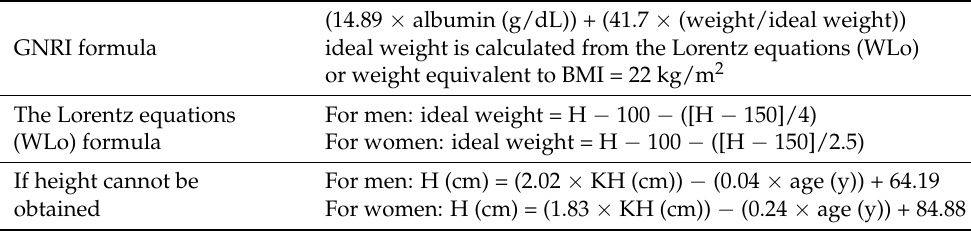
Table 1. Geriatric Nutritional Risk Index